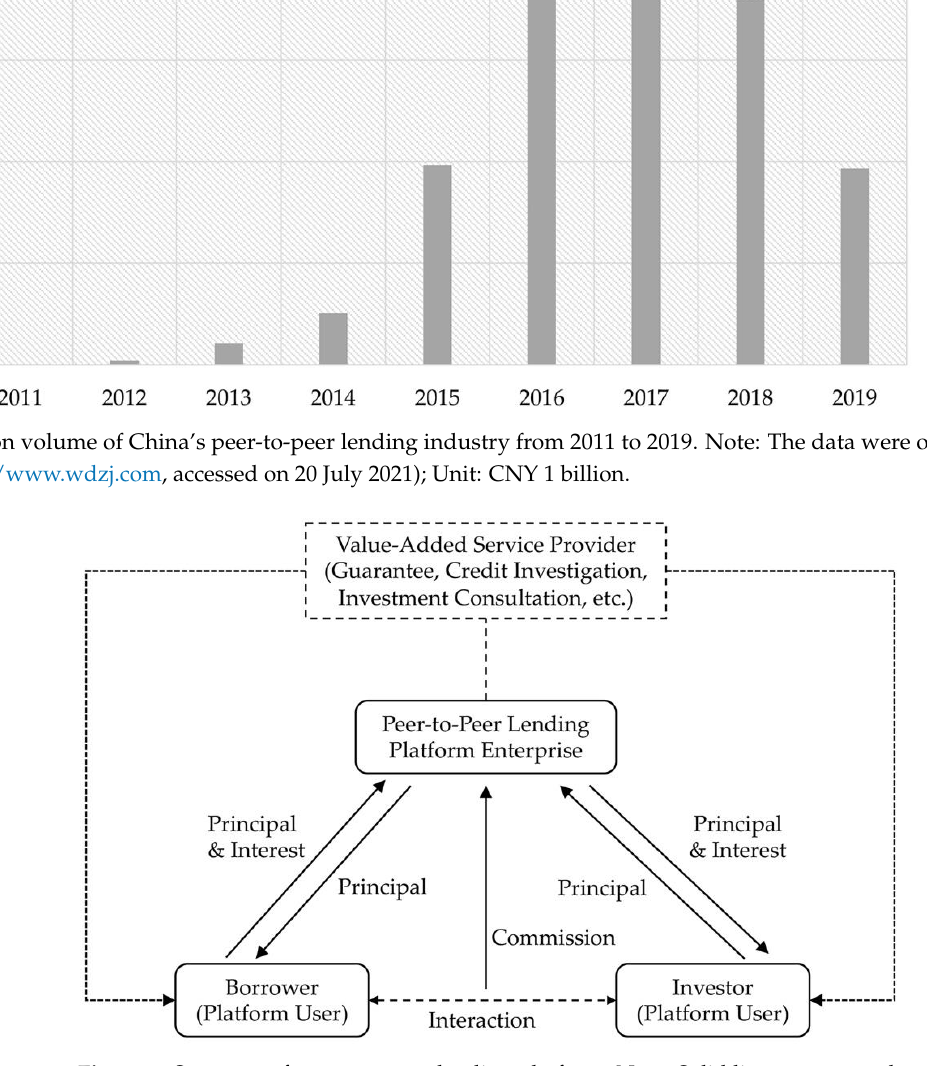
Figure 2. Structure of a peer-to-peer lending platform. Note: Solid line represents the capital flow of